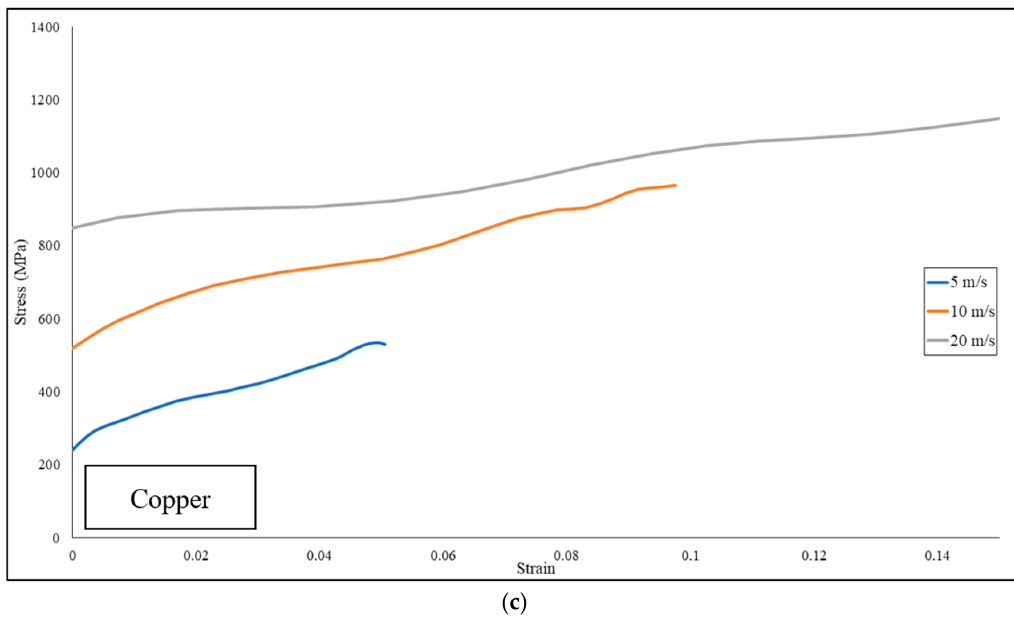
Figure 15. Stress–strain curve with loading velocity at 5, 10, and 20 m/s for ( a ) aluminum, ( b ) steel, and ( c ) copper.